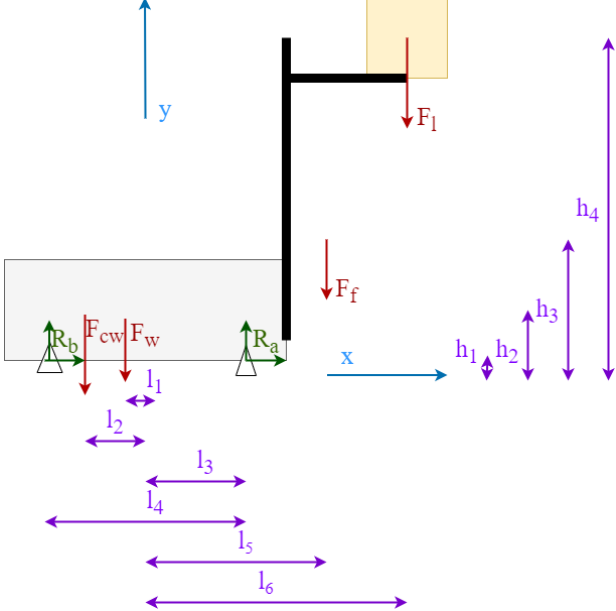
Figure 17. Schematical illustration of the case study and its loads. Table 7. Variables and their